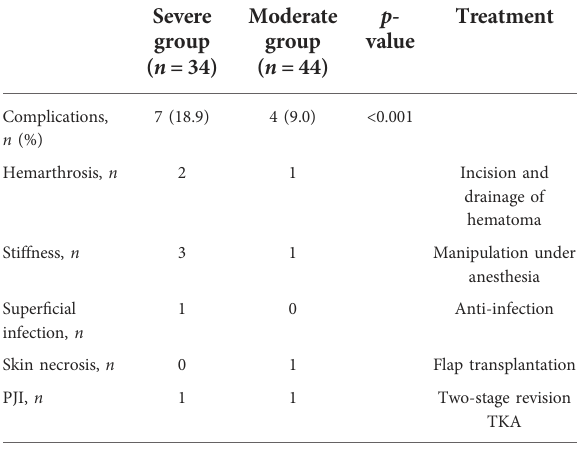
TABLE 5 Postoperative complications between the severe and moderate groups.